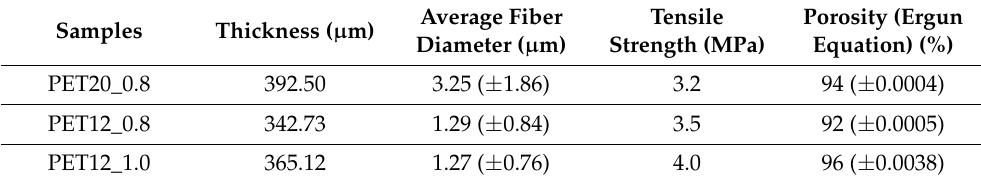
Table 2. Characterization of PET fibrous